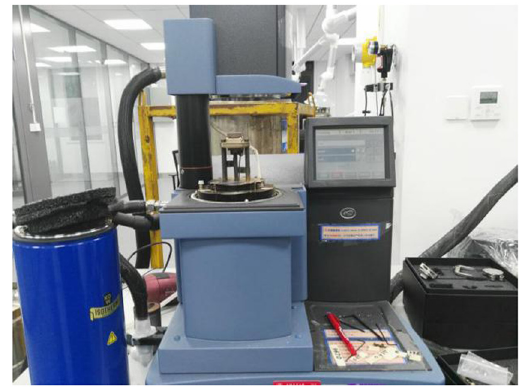
Figure 2: Dynamic thermo - mechanical analysis